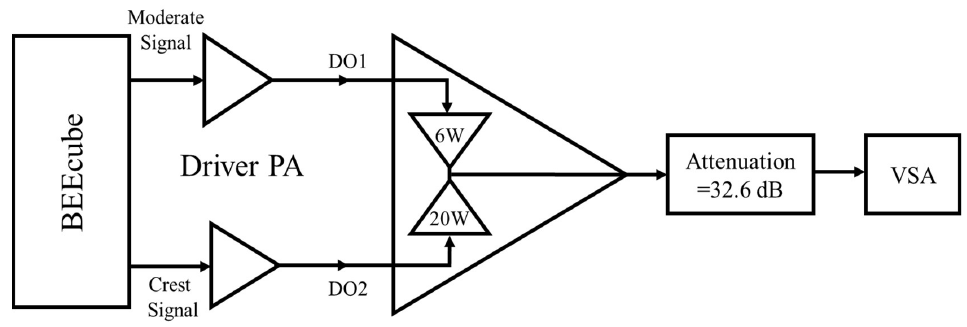
Figure 8. Normalized input and output three-level DSM signal after QNRIF.